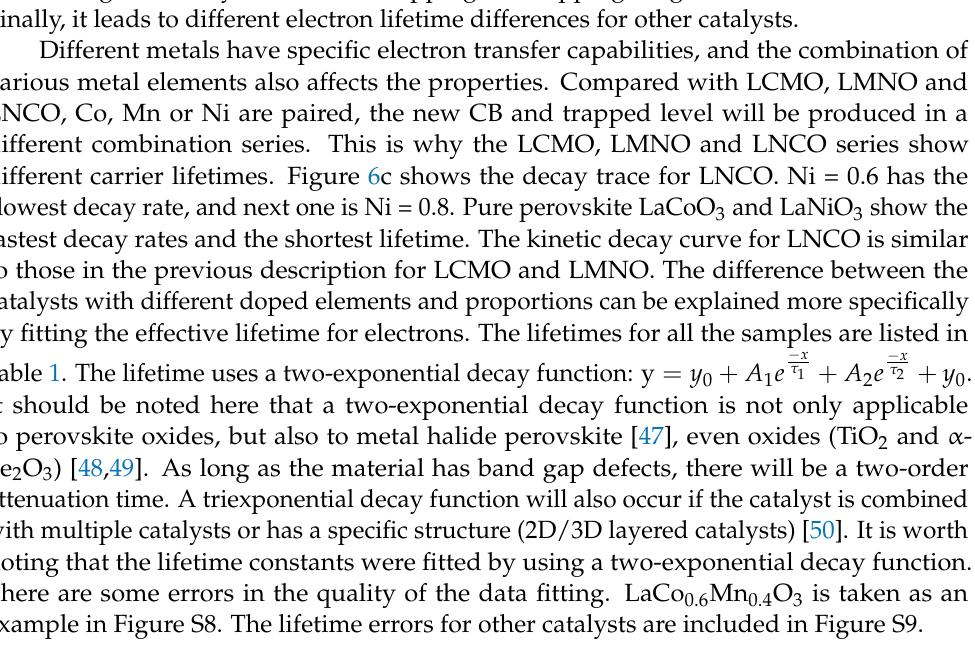
Table 1. The lifetime uses a two-exponential decay function: y = y 0 + A 1 e